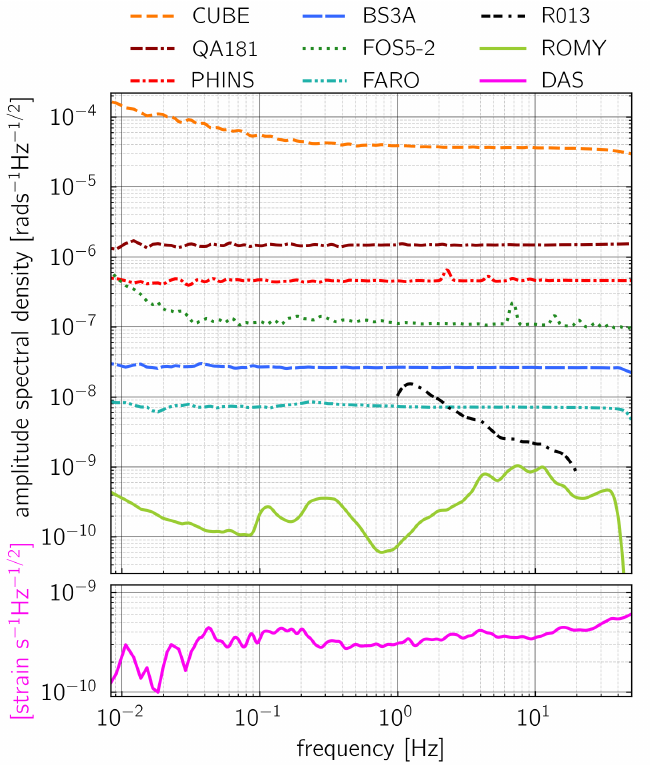
Figure 4. Amplitude spectral densities from night time recordings of vertical rotation rate during the huddle test on 19 November 2019. The spectrum from the ROMY ringlaser recording represents the seismic background noise. The spectra from the other rotation rate sensors represent the instrument self-noise of the tested rotational motion sensors. The amplitude spectrum of a parallel recording of the axial strain rate at the DAS measurement point closest to the huddle test site pointing to 300 ◦ with respect to North is shown in the lower